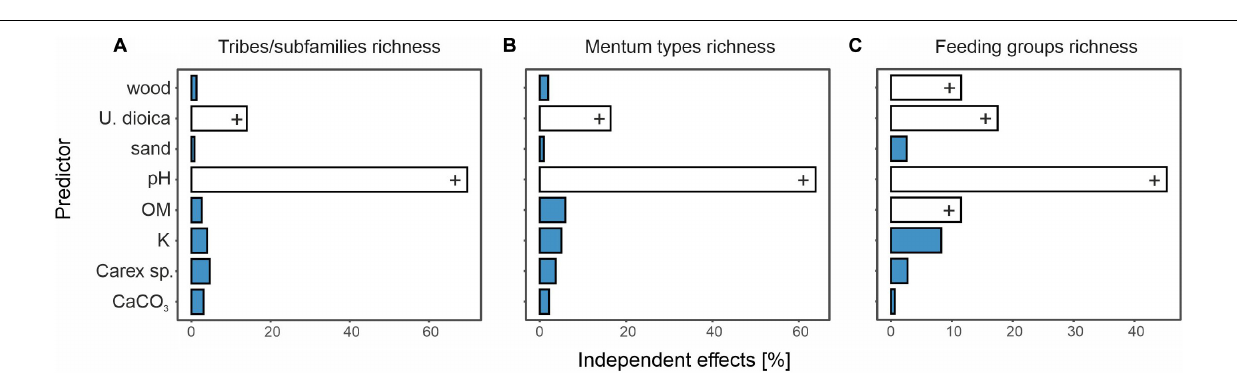
Supplementary Table 2 . For final values of each environmental factor in averaged models, see Supplementary Table 3